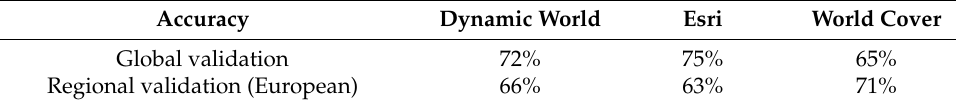
Figure 4. Spatial correspondence between global 10 m land cover maps for each of 9 land cover classes. The proportion of land cover within each hexagonal grid cell is calculated for each LULC product and then visualized along a tri-color gradient illustrating the proportional share of areas estimated by each LULC product. Gray areas indicate strong correspondence, whereas colored areas reflect dominance of one LULC product. Gric cells outlined in black indicate strong correspondence, defined as cases where no single LULC product has more than 40% share of the combined area within the grid cell. The opacity of the grid cells indicates the absolute percentage abundance of each LULC class averaged over the three LULC classes. Opaque areas have near-maximum percentage cover for that LULC class, whereas transparent areas have very low percentage cover. Table 3. Summary of overall accuracies quantified at the global and regional